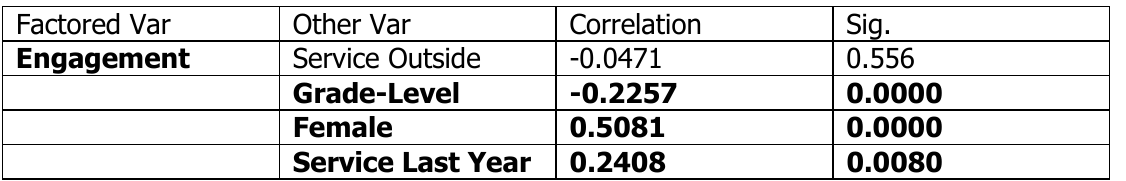
Student Engagement – Spring